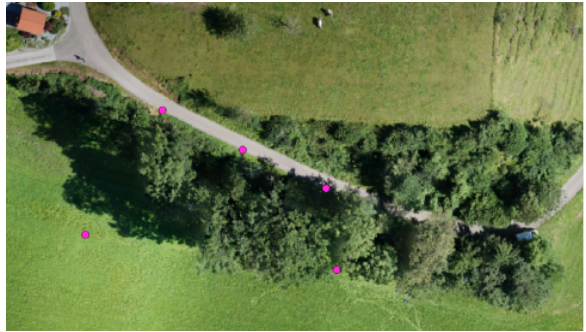
Figure 3. Orthophoto of Test site "Rietholzbach" with ground control points (purple).